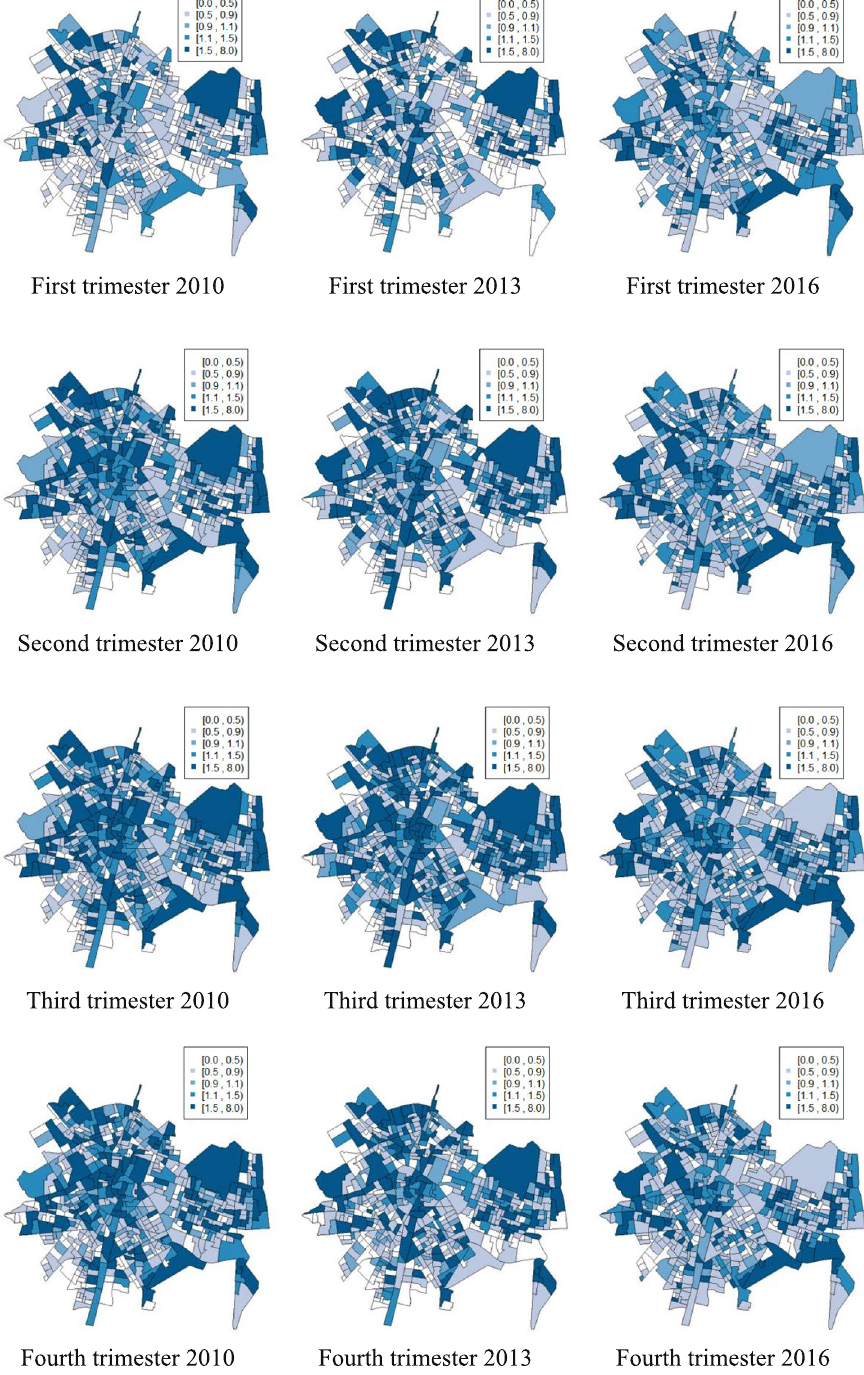
Figure 1. Relative risk for the four trimesters of 2010, 2013 and 2016 (maps created by the software R version 3.4.3., available in